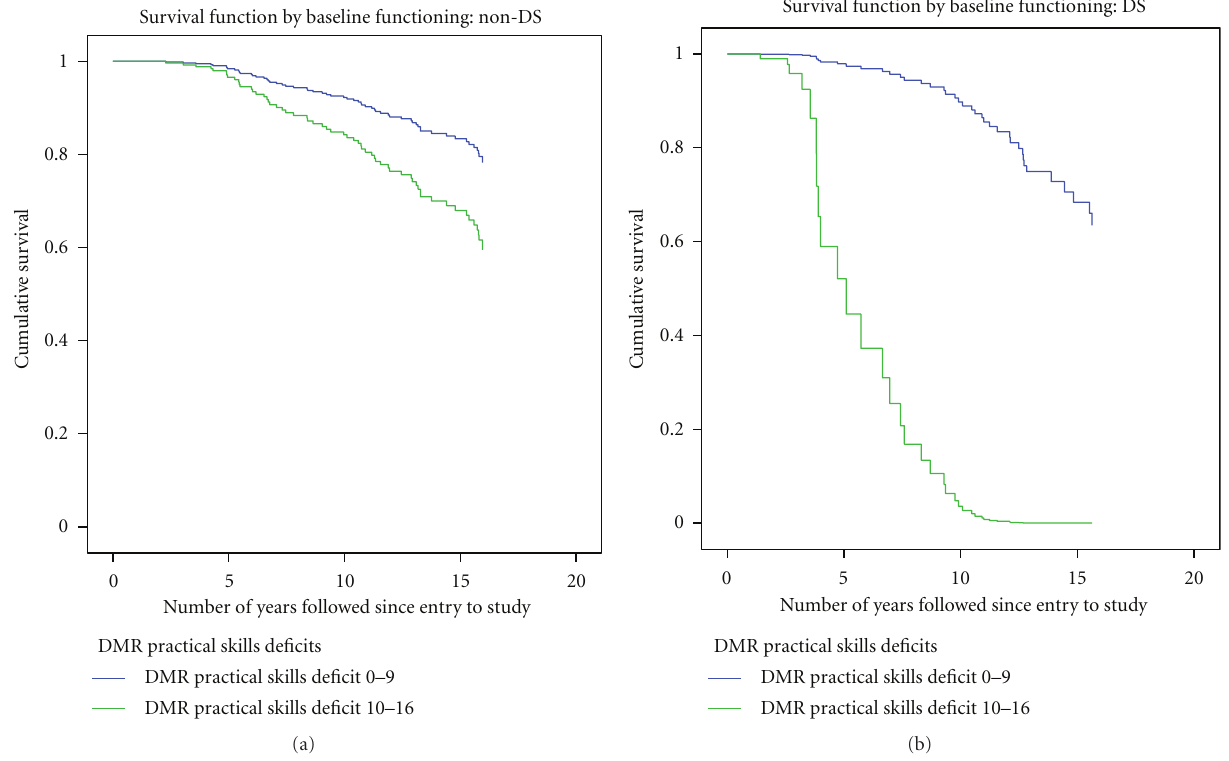
Figure 5: Adjusted survival curves of 360 participants with ID (1995–2011): impact of baseline functional deficits: non-DS compared to